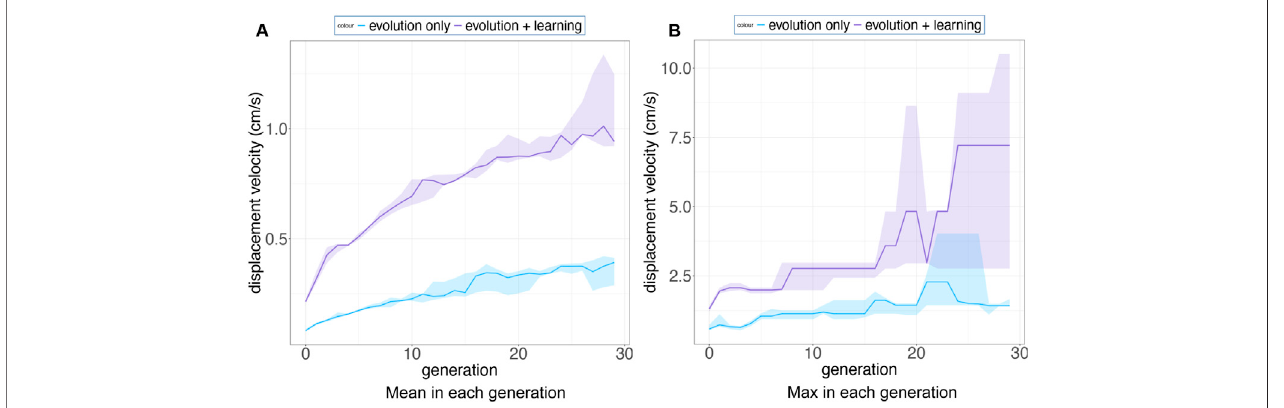
FIGURE15 | Sub fi gure (A) shows the mean displacement velocity over 30generations(averagedover 10runs) forEvolution-Only in blue and Evolution + Learning inpurple.Sub fi gure (B) exhibitsthemaximumdisplacementvelocityineachgeneration(averagedover10runs).Theshadedareasshowthestandarddeviation.Notethe different scales on the vertical